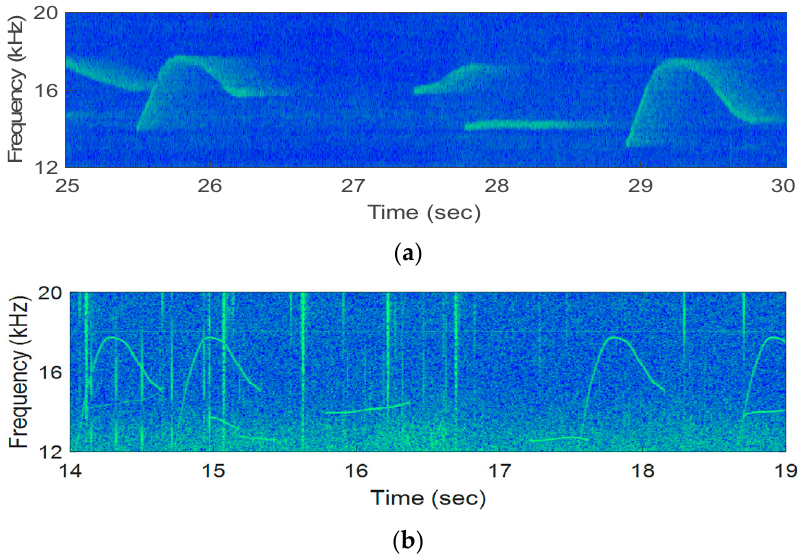
Figure 13. Experiments received signals: ( a ) Ocean, ( b ) Lake.